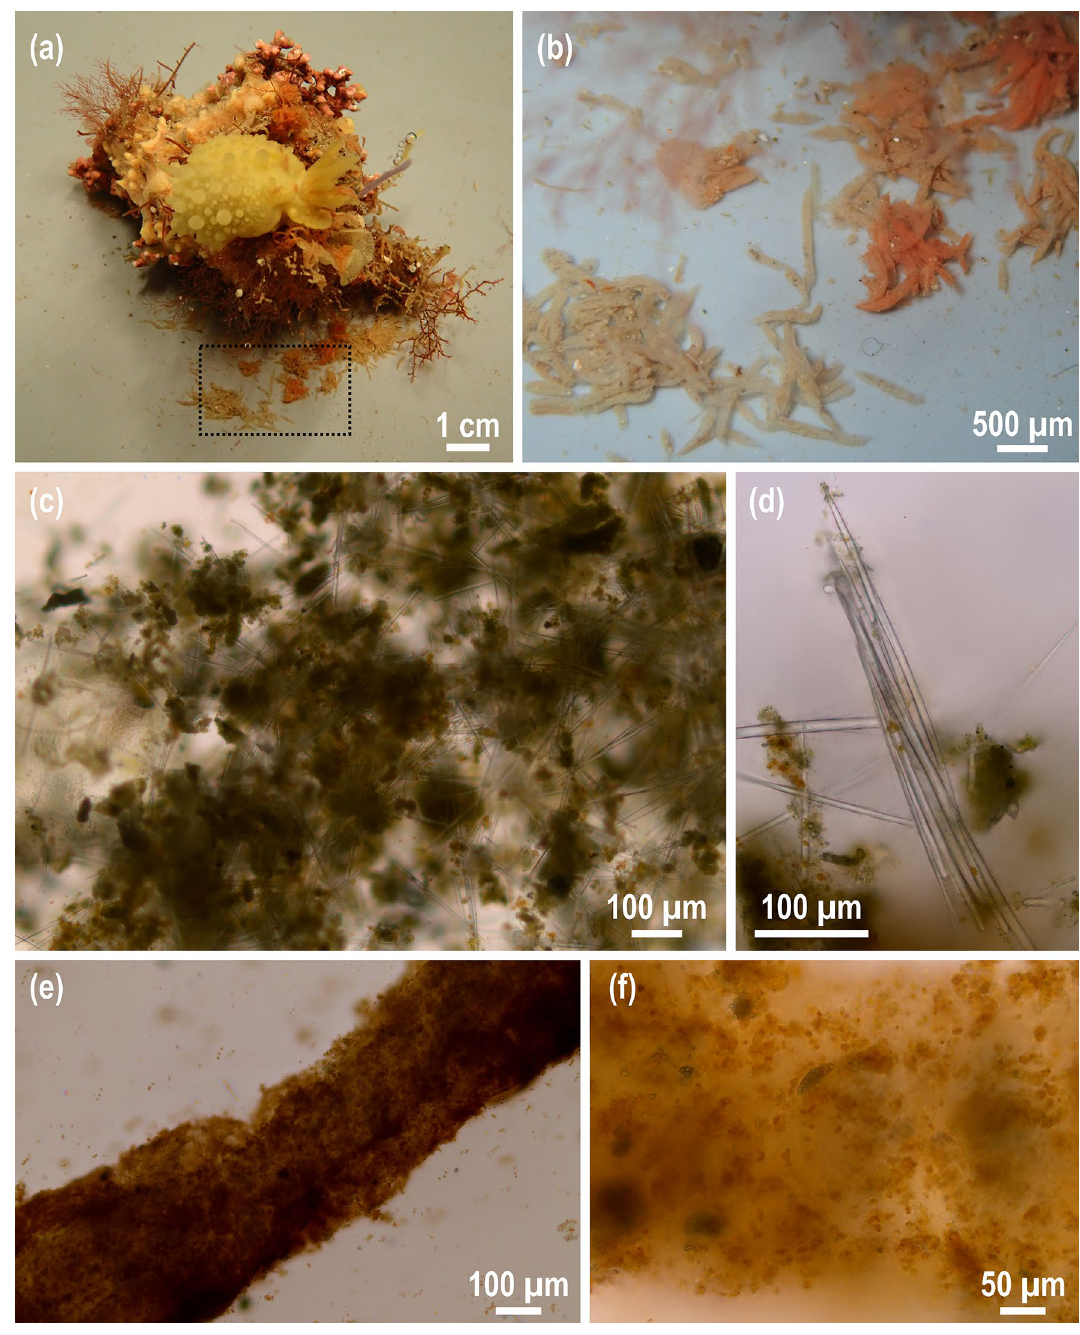
Figure 4. ( a ) The nudibranch Doris verrucosa feeds on the sponge Hymeniacidon perlevis after 72 h of aquarium incubation to assess the silicon export through nudibranch feces. ( b ) Enlargement of the dotted quadrat of ( a ), in which two types of fecal pellets are recognizable: colorless (left) and colored (right) pellets, the latter ones colored with the same pigments existing in the eaten sponge. ( c , d ) Microscopic view of colorless fecal pellets of D. verrucosa . Colorless feces, less structured than colored ones, are loaded with sponge spicules, which are mostly unbroken. In some cases ( d ), spicules still have the same structural organization as in the sponge. ( e , f ) Microscopic view of colored fecal pellets of D. verrucosa . Colored feces are more structured than colorless ones and mainly contain organic excretory